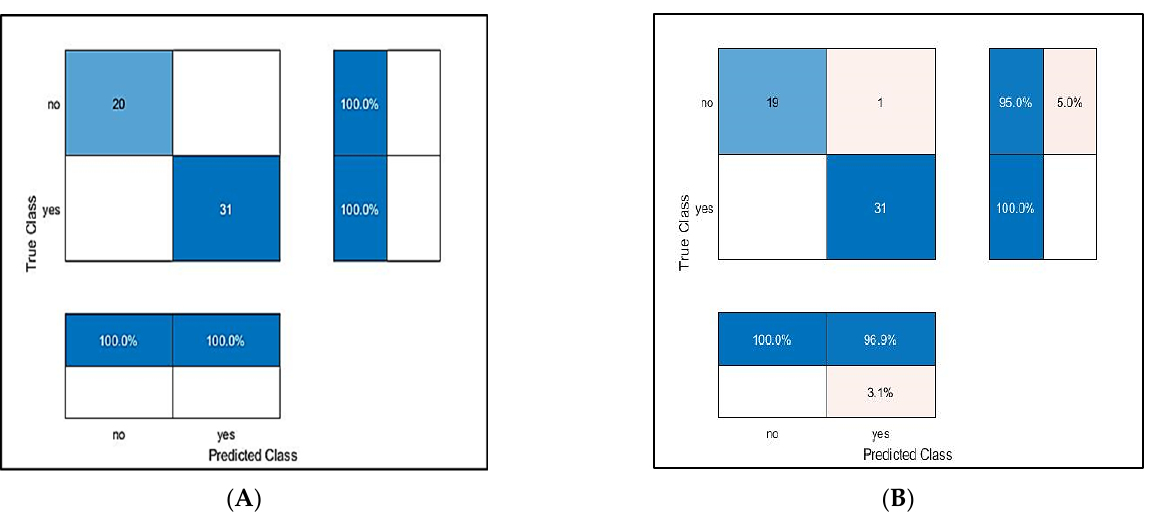
Figure 14. Results of proposed method using public dataset. ( A ): Results of SN-SVM method. ( B ): Results of SN-FT method. Table 6. Performance results using public dataset .